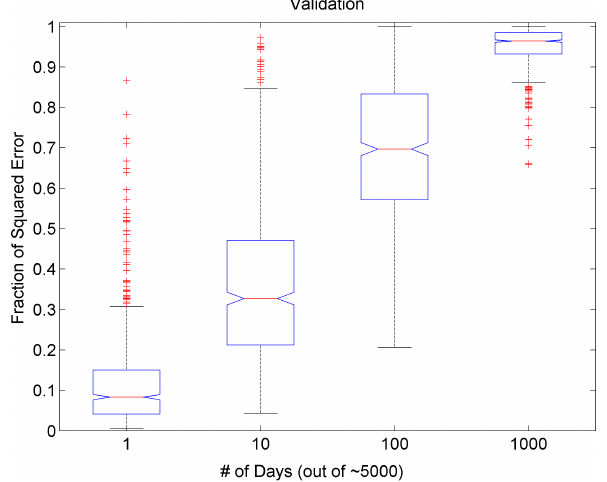
Figure 10. Fractional contribution of the total squared error for the 1, 10, 100, 1000 largest error days. The box plots represent the 671 basins with the blue area defining the interquartile range, the whiskers representing reasonable values and the red crosses denot- ing outliers. The median is given by the red horizontal line with the notch in the box denoting the 95% confidence interval of the median value.